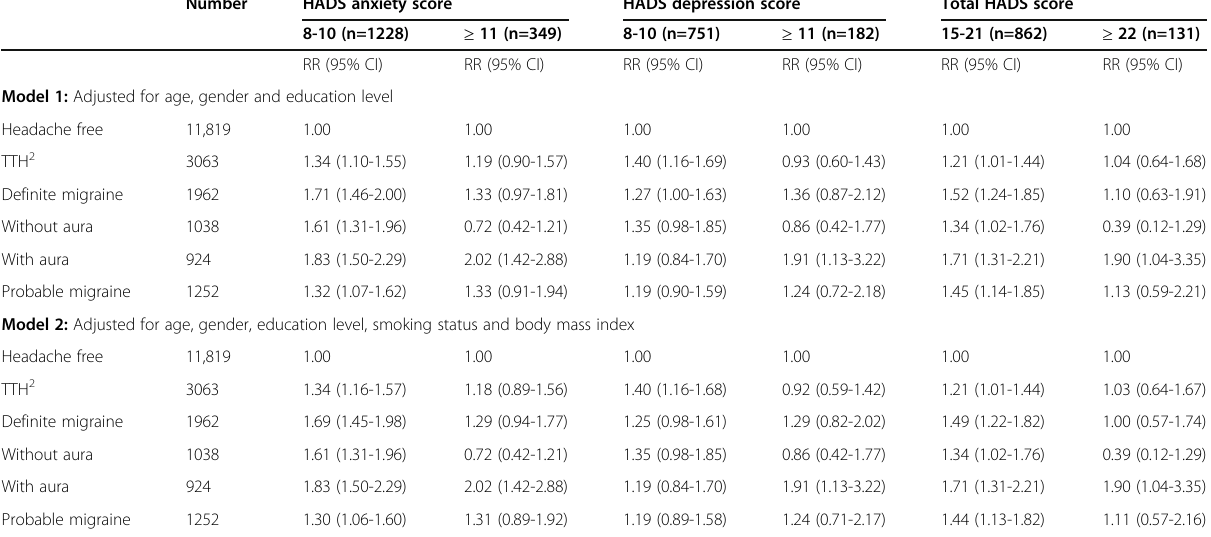
Table 3 HADS 1 anxiety and depression score ≤ 7 in HUNT3 ( n =18,380): Risk of elevated HADS 1 score in HUNT4 based on headache diagnoses in HUNT3 evaluated by poisson regression with 95% confidence interval